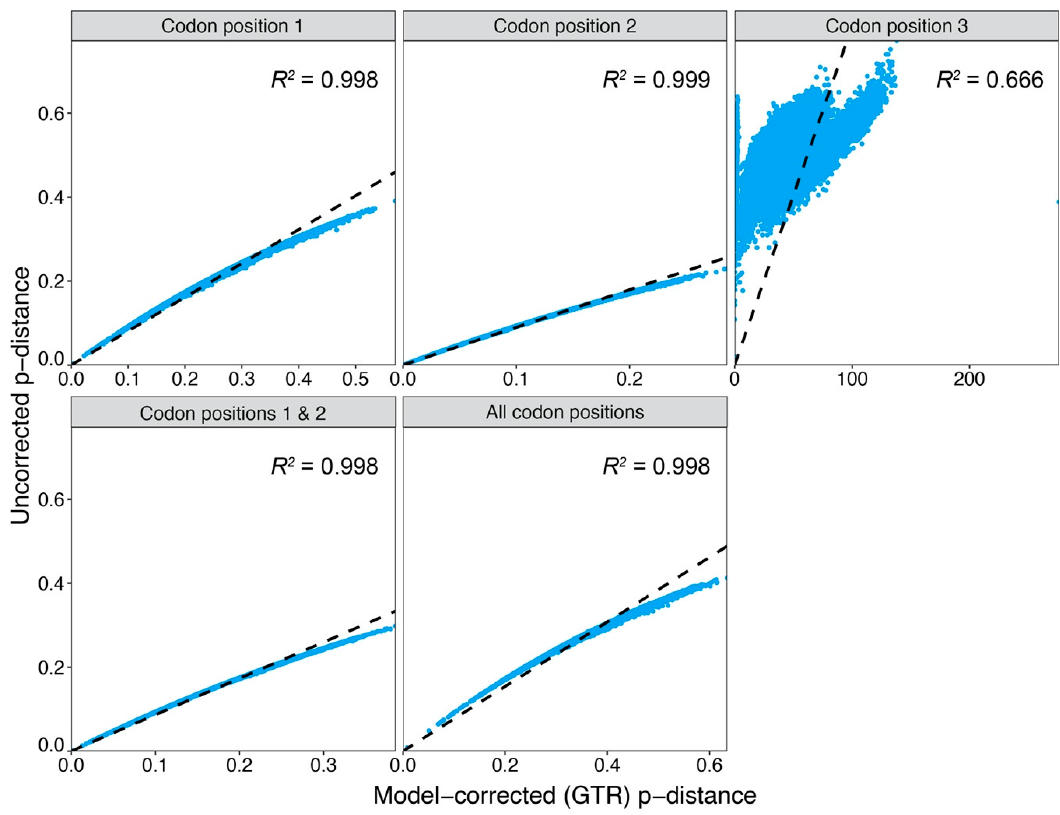
Figure 1. Substitution saturation plots showing the linear relationship between uncorrected and model-corrected (GTR) genetic distances for cytochrome oxidase subunit 1 (COI) codon position 1–3, codon positions 1 and 2 combine, and all codon positions combined. The linear regression (dotted line) and coe ffi cient of determination ( R 2 ) are indicated for each